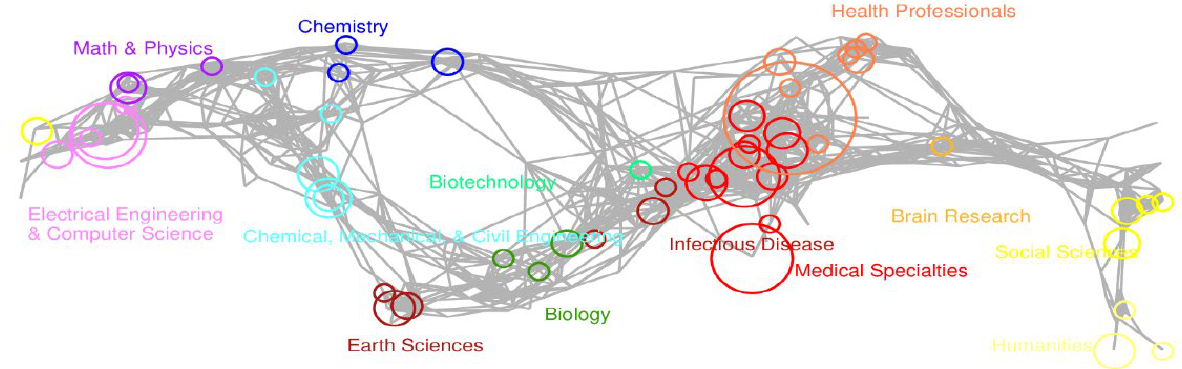
Figure 7. Map of science. Visual representation of 554 subdiscipline nodes connecting a total of 55 subdisciplines and 13 disciplines (from left to right: Electrical Engineering and Computer Sciences; Math and Physics; Chemical, Mechanical and Civil Engineering; Chemistry; Earth Sciences; Biotechnology; Biology; Infectious Disease; Medical Specialties; Health Professionals; Brain Research; Humanities; Social Sciences). Each discipline has a distinct color and is labeled. Overlaid are circles, each representing all records per unique subdiscipline. The circle area is proportional to the number of fractionally assigned records. Minimum and maximum data values correspond to 0 and 26, respectively. Mapped subdisciplines are shown by size related to the number of matching journals and colors for the discipline. Created with Sci2 Tool (https://sci2.cns.iu.edu; accessed on 17 January 2023).